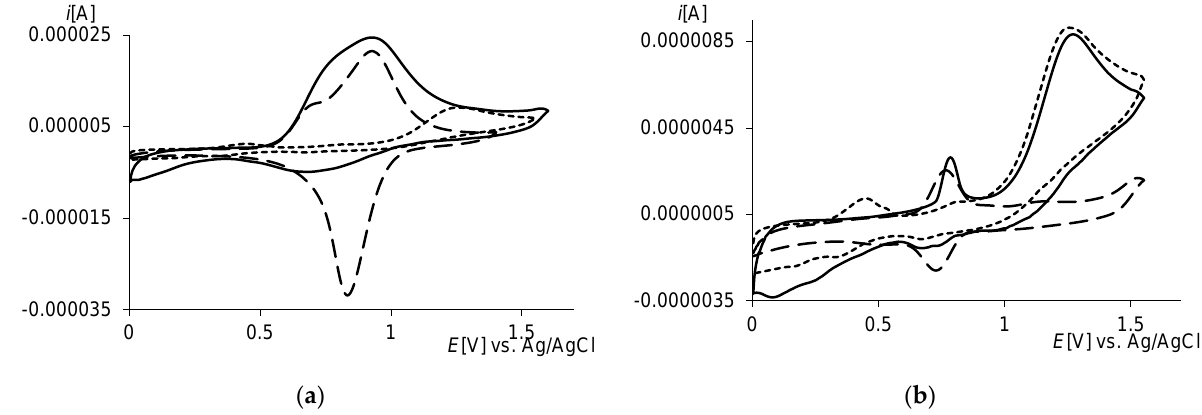
Figure 3. Cyclic voltammograms, 2nd scans, v = 0.05 V · s − 1 , vs. Ag/AgCl. Modified electrodes in TBAH (0.1 mol · dm − 3 )/AN (after electropolymerization: 3 scans, v = 0.05 V · s − 1 )—dashed lines, modified electrodes in ascorbic acid(10 − 3 mol · dm − 3 )/TBAH/AN—solid lines; Pt in ascorbic acid/TBAH/AN — dotted lines. ( a ) Pt poly [Ni(salcn)], ( b ) Pt poly [Ni(salcn(Bu))].